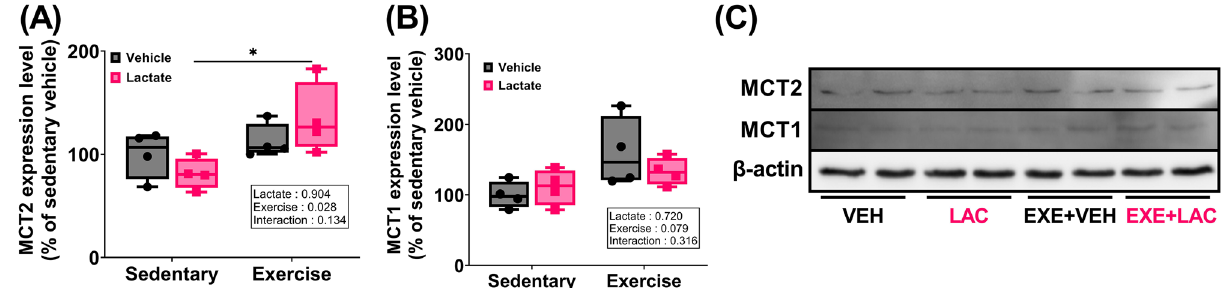
Figure 7. Exercise with lactate administration effectively enhanced the hippocampal MCT2 protein expression but not MCT1. Level of protein expression of hippocampal ( A ) MCT2 and ( B ) MCT1 in mice. ( C ) The represent image of western blot. Two-way ANOVA was performed, and independent Student’s t -test was used for post hoc test ( n = 4 per group). The original blots are presented in Supplementary Fig. 3. VEH sedentary without lactate, LAC sedentary with lactate, EXE + VEH exercise without lactate, EXE + LAC exercise with lactate, MCT1/2 monocarboxylate transporter 1/2; * p < 0.05. Data are presented as box plot.